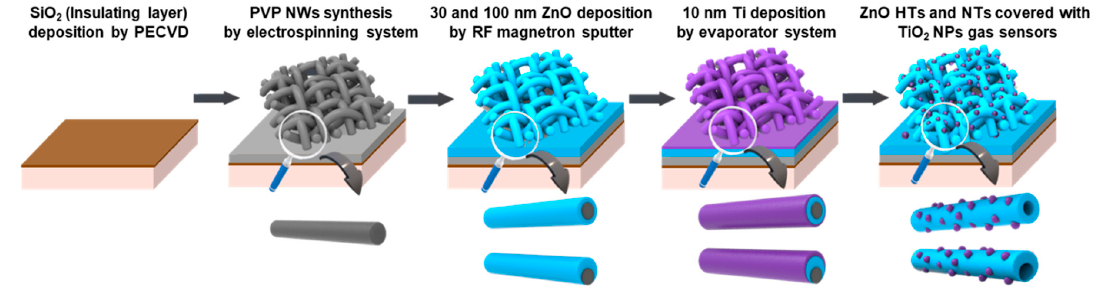
Figure 1. Fabrication procedure for gas sensors consisting of ZnO hemitubes (HTs) and nanotubes (NTs) covered with TiO 2 nanoparticles (NPs) .